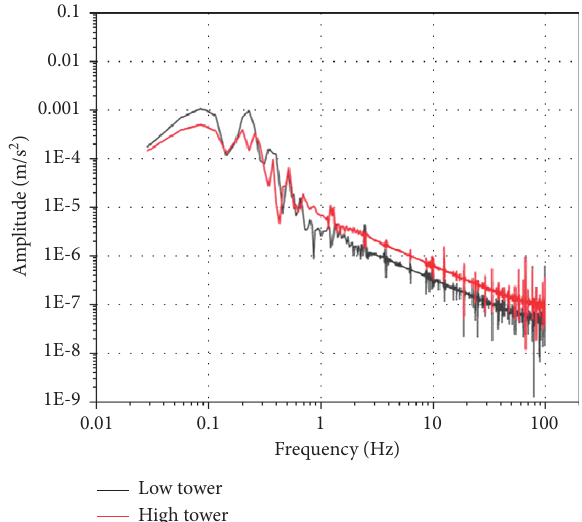
Figure 16: Comparison of vertical vibration acceleration fre- quency-domain curves at L1 and R1.